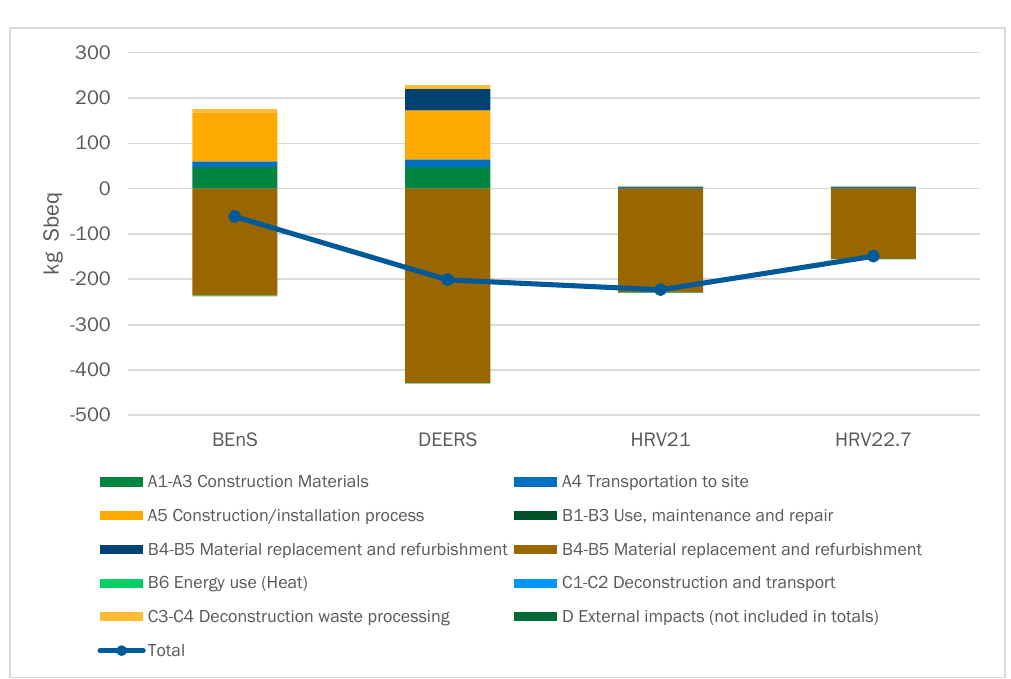
Figure 5. Abiotic depletion potential of non-fossil elements (Sbeq).